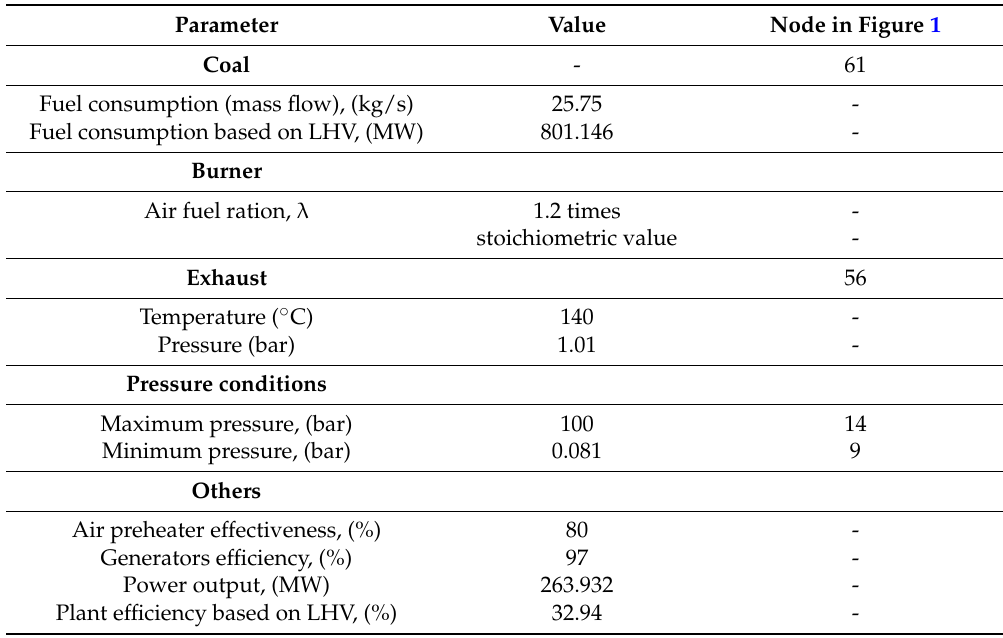
Table 2. The main plant